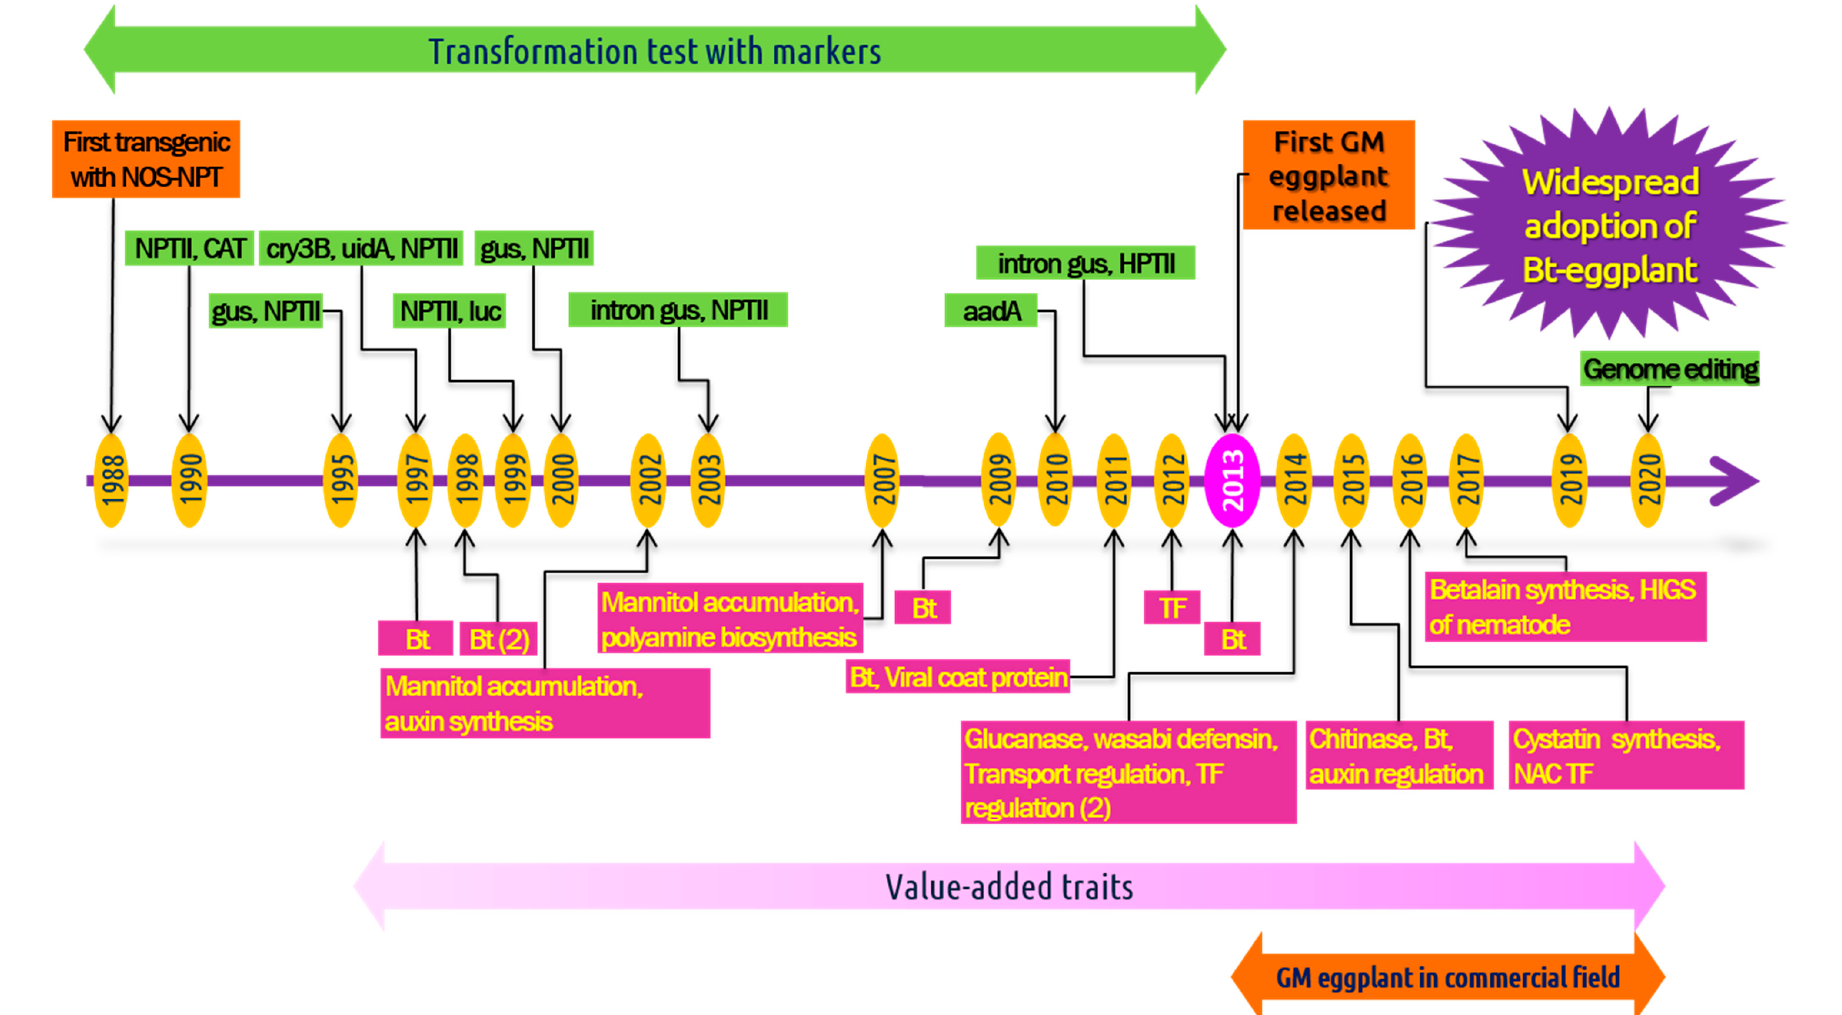
Figure 2. Timeline of the engineering of eggplant—from the first report to the commercialization. Multiple publications in the same year are mentioned in parenthesis.